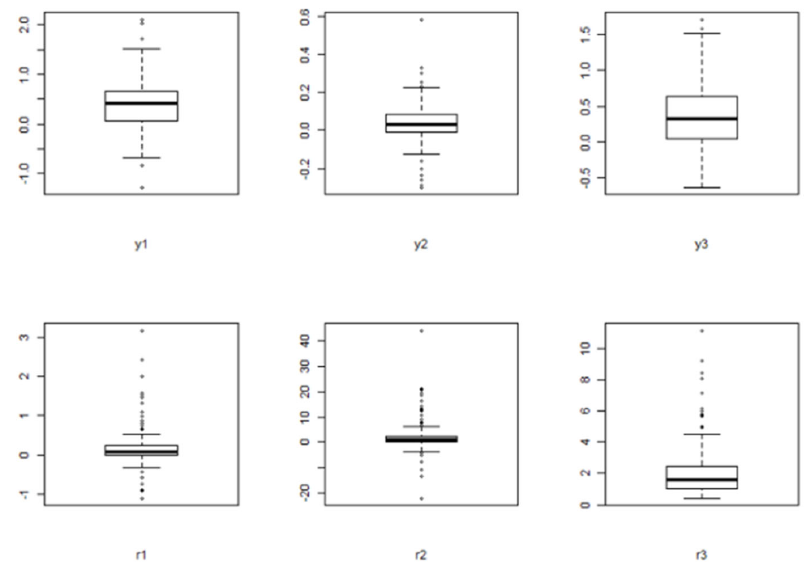
Fig. 1. Box plots of the standard indicators r 1 to r 3 and compositional indicators y 1 to y